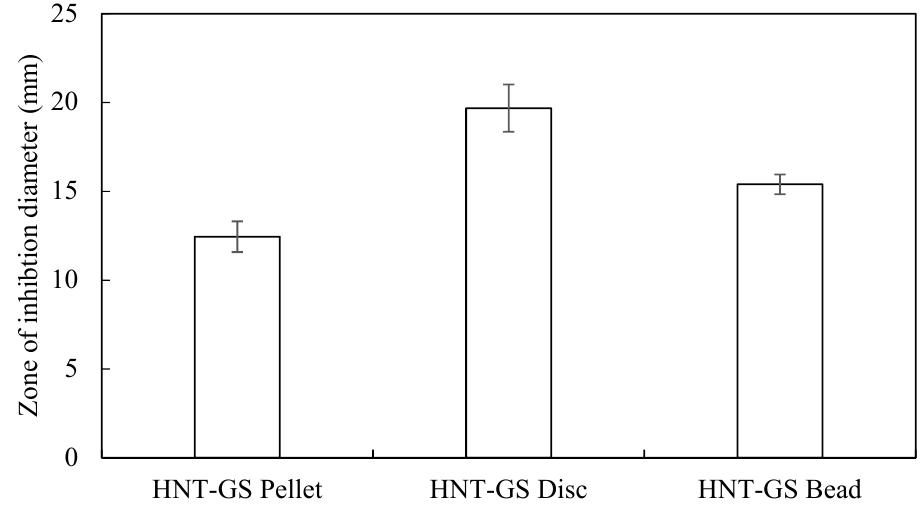
Figure 7. Zone of inhibition diameters for different HNT-GS constructs against E. coli (mean ± SD, n = 3).